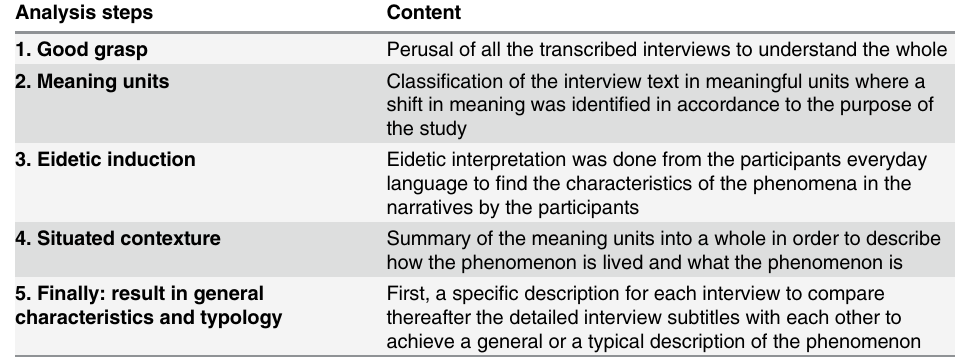
Table 2. The five steps for the analysis according to empirical phenomenological psychology (EPP) by G. Karlsson